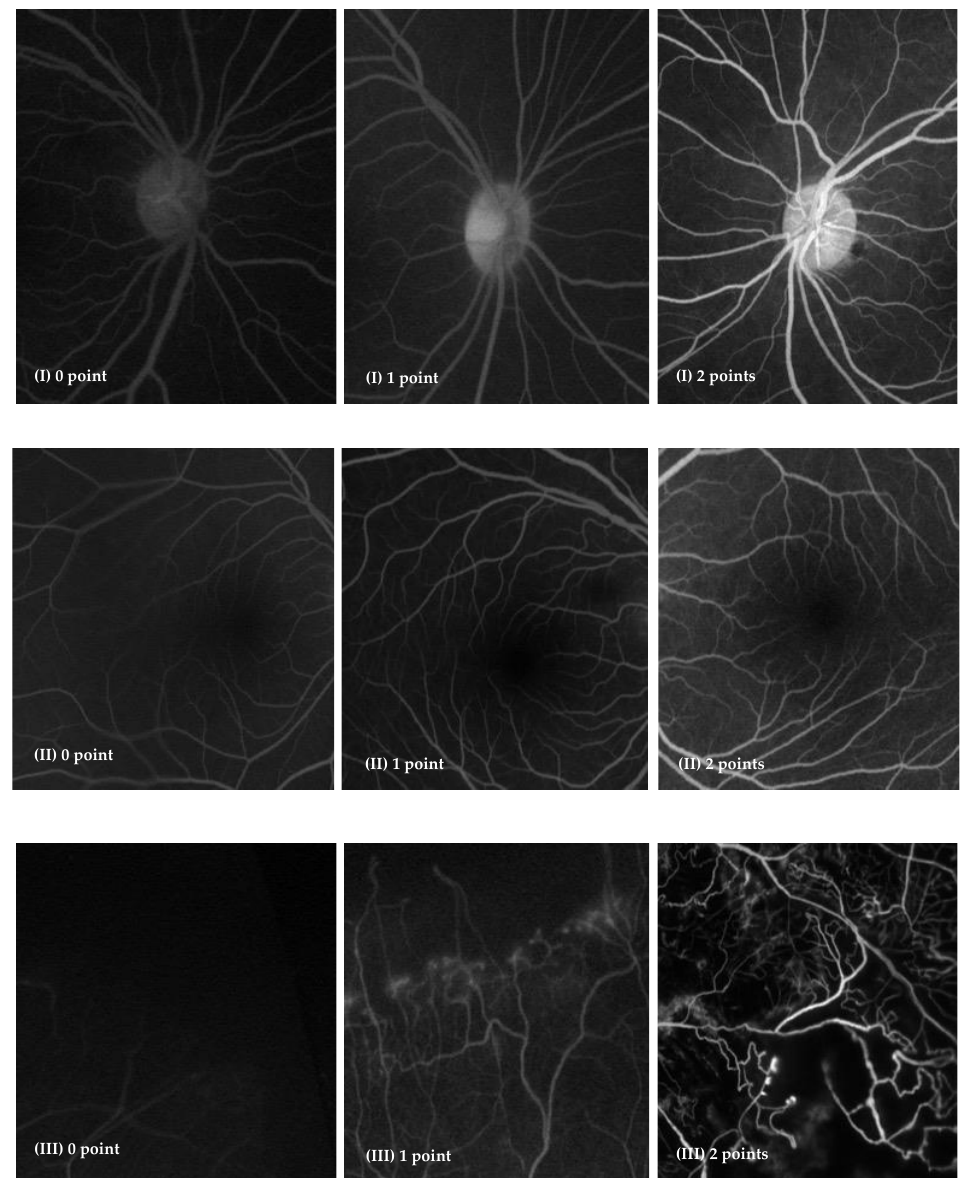
Figure 1. Representative images of each score regarding parameters I, II and III.